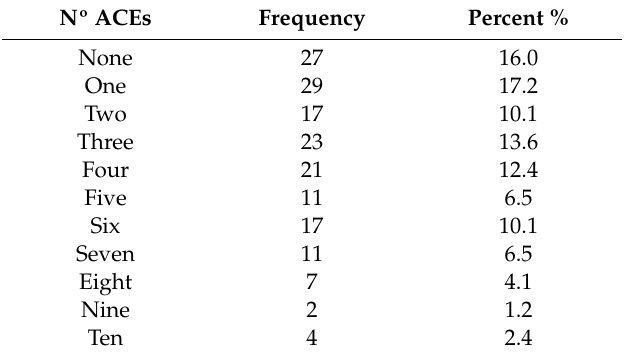
Table 2. Frequency and percentage of adverse childhood experiences (ACEs).